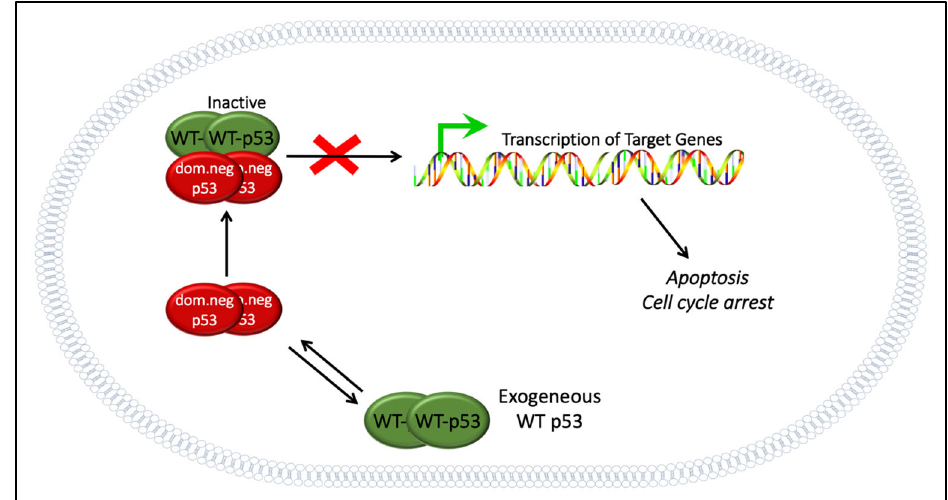
Figure 3. Why wild-type (WT) p53 gene therapy is not effective: dominant negative effect. Endogenous mutant p53 (dominant negative) found in cancer cells can tetramerize and inactivate any exogenously added WT p53. This inactive heterotetramer cannot bind to, nor activate, target genes. The result is that WT p53 cannot execute apoptosis nor cell cycle arrest. Bypassing the dominant negative effect may be possible with re ‐ engineered p53 chimeras that do not bind to dominant negative p53 [52,104–106] .